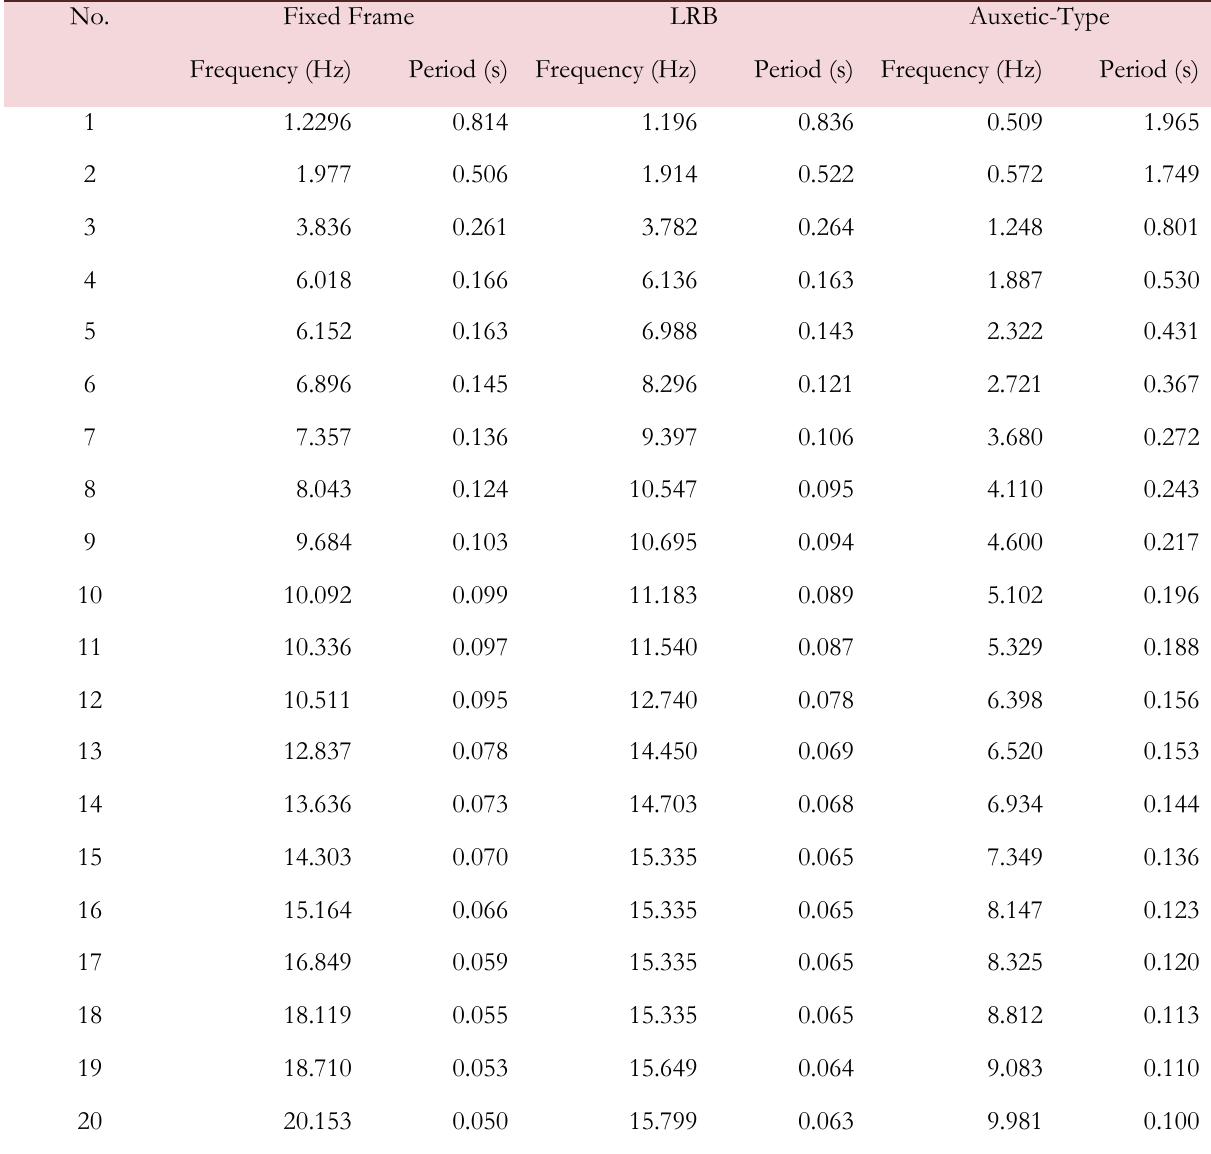
Table 4: Eigenvalue analysis